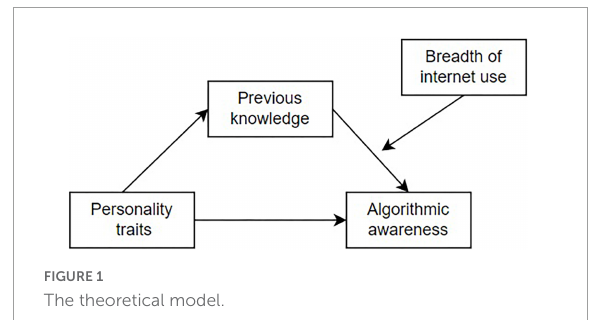
FIGURE1 The theoretical